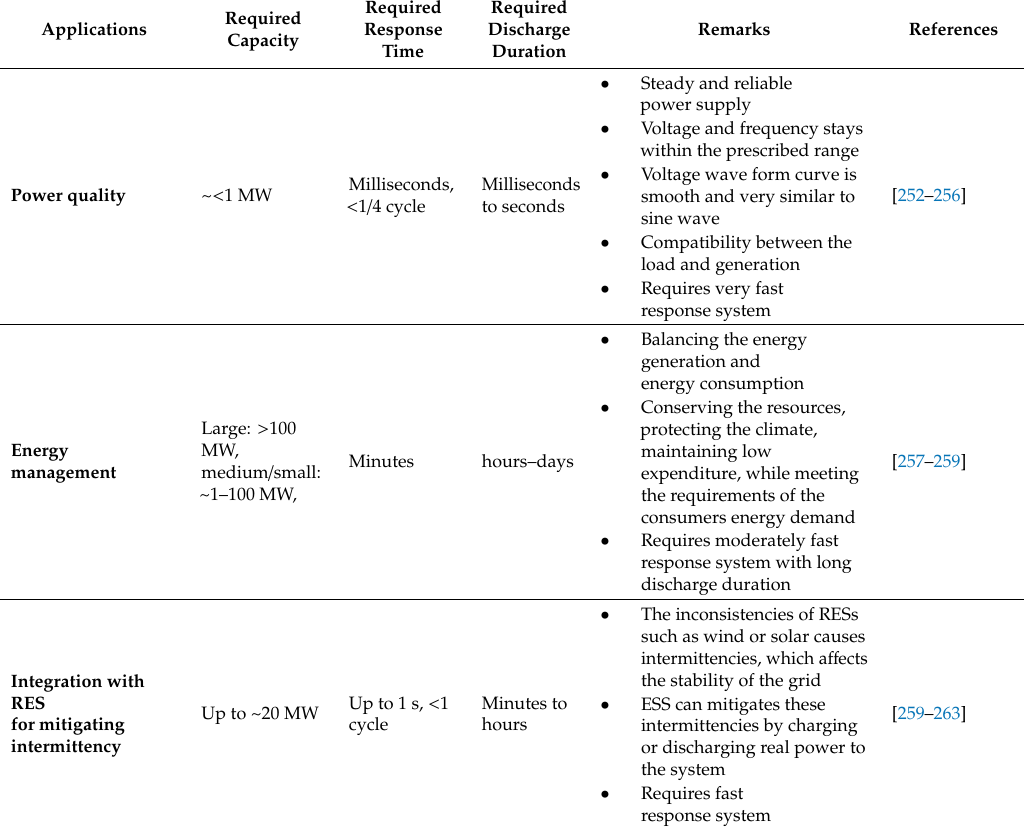
Table 18. Di ff erent applications of ESS along with their required capacity, response time, and discharge